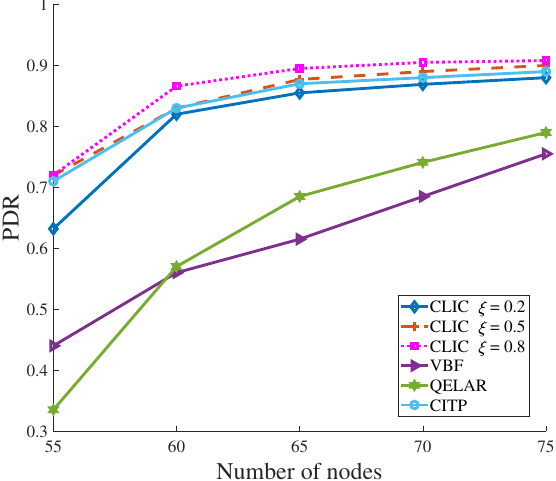
Figure 10. Comparison of PDR versus the number of